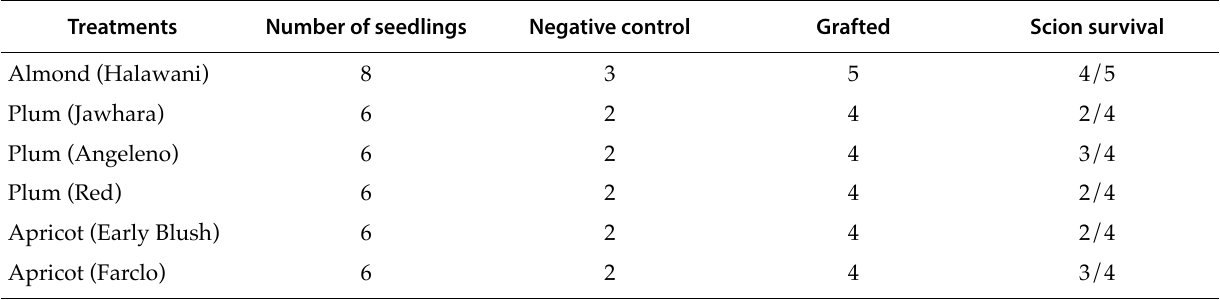
Table 1. Greenhouse grafting experiment: number of AlmWB phytoplasma-infected scions that successfully grew 2 months post